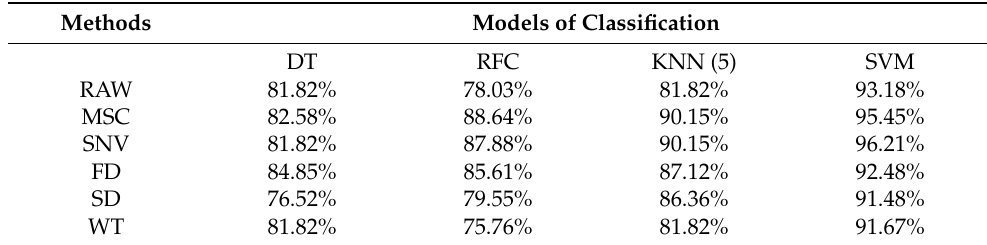
Table 1. Detection results based on different models of various preprocessing